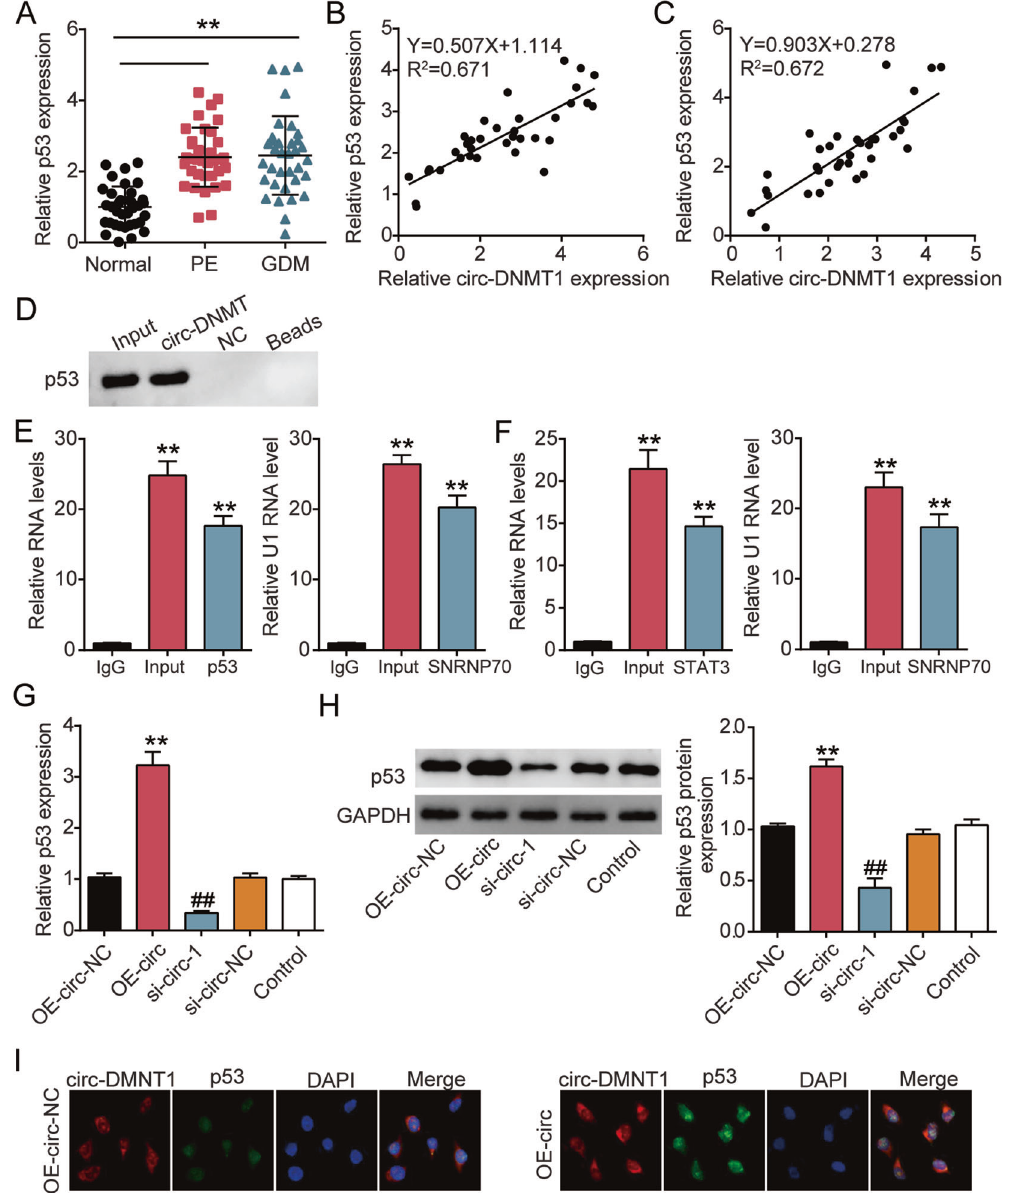
Fig. 4 Circ-DMNT1 binded to p53 in trophoblast cells. A qRT-PCR analysis of p53 expression in PE ( N = 35) and GDM placentas ( N = 35). ** P < 0.001. B The correlation between circ-DMNT1 and p53 in PE placentas was analyzed by Pearson analysis. C The correlation between circ- DMNT1 and p53 in GDM placentas was analyzed by Pearson analysis. D The interaction between circ-DMNT1 and p53 was detected by RNA pull-down assay. E RIP with rabbit monoclonal anti-p53 and preimmune IgG from HTR-8/SVneo cell extracts. RNA levels in immunoprecipitates were determined by qPCR. Expression levels of circ-DMNT1 RNA are presented as fold-enrichment in p53 relative to IgG immunoprecipitates; U1 binding with SNRNP70 is a positive control. ** P < 0.001 compared with IgG. F RIP with rabbit monoclonal anti-p53 and preimmune IgG from HTR-8/SVneo cell extracts. RNA levels in immunoprecipitates were determined by qPCR. Expression levels of STST3 RNA were presented as fold enrichment in p53 relative to IgG immunoprecipitates, U1 binding with SNRNP70 is a positive control. ** P < 0.001 compared with IgG. G Expression of p53 mRNA was downregulated by the si-circ-1 but was upregulated by the OE-circ in HTR-8/SVneo cells. ## P < 0.001 compared with si-circ-NC. ** P < 0.001 compared with OE-circ-NC. H Expression of p53 protein was upregulated by the si-circ-1 but was downregulated by the OE-circ in HTR-8/SVneo cells. ** P < 0.001 compared with OE-circ-NC. ## P < 0.001 compared with si-circ-NC. I The localization and expression of p53 (green) in HTR-8/SVneo cells overexpressed circ-DMNT1 (red) were detected by IF and FISH. DAPI was used for nuclear staining. N = 3, repetition = complex of circ-DMNT1 compared with NC (Fig. 4D). Moreover, RIP detection was performed to verify the binding relationship between circ-DMNT1 and p53 using U1 binding SNRNP70 as a positive control, and it was found that circ-DMNT1 directly bound p53 in HTR-8/SVneo cells (Fig. 4E). It has been reported that p53 interacts with STAT3 mRNA and regulates its expression [20].